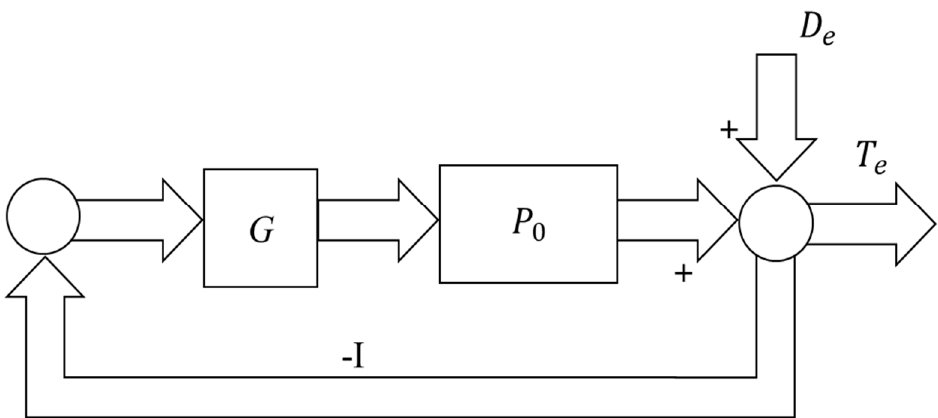
Figure 3. Equivalent disturbance attenuation structure for the feedback controller design in model matching problem.